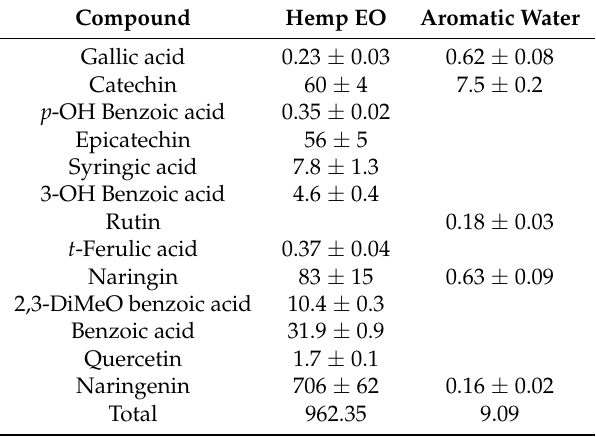
Table 4. Quantitative ( µ g/mL) * multicomponent phenolic pattern in test